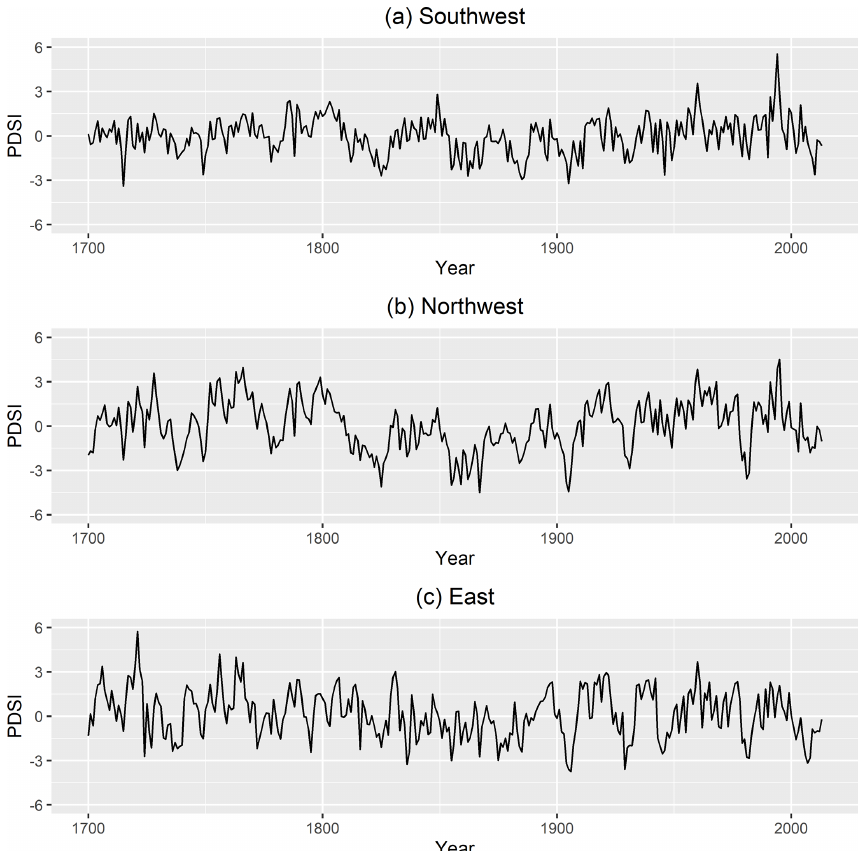
Figure 3. Time series of the tree-ring-reconstructed PDSI in (a) the southwest, (b) the northwest, and (c) the east